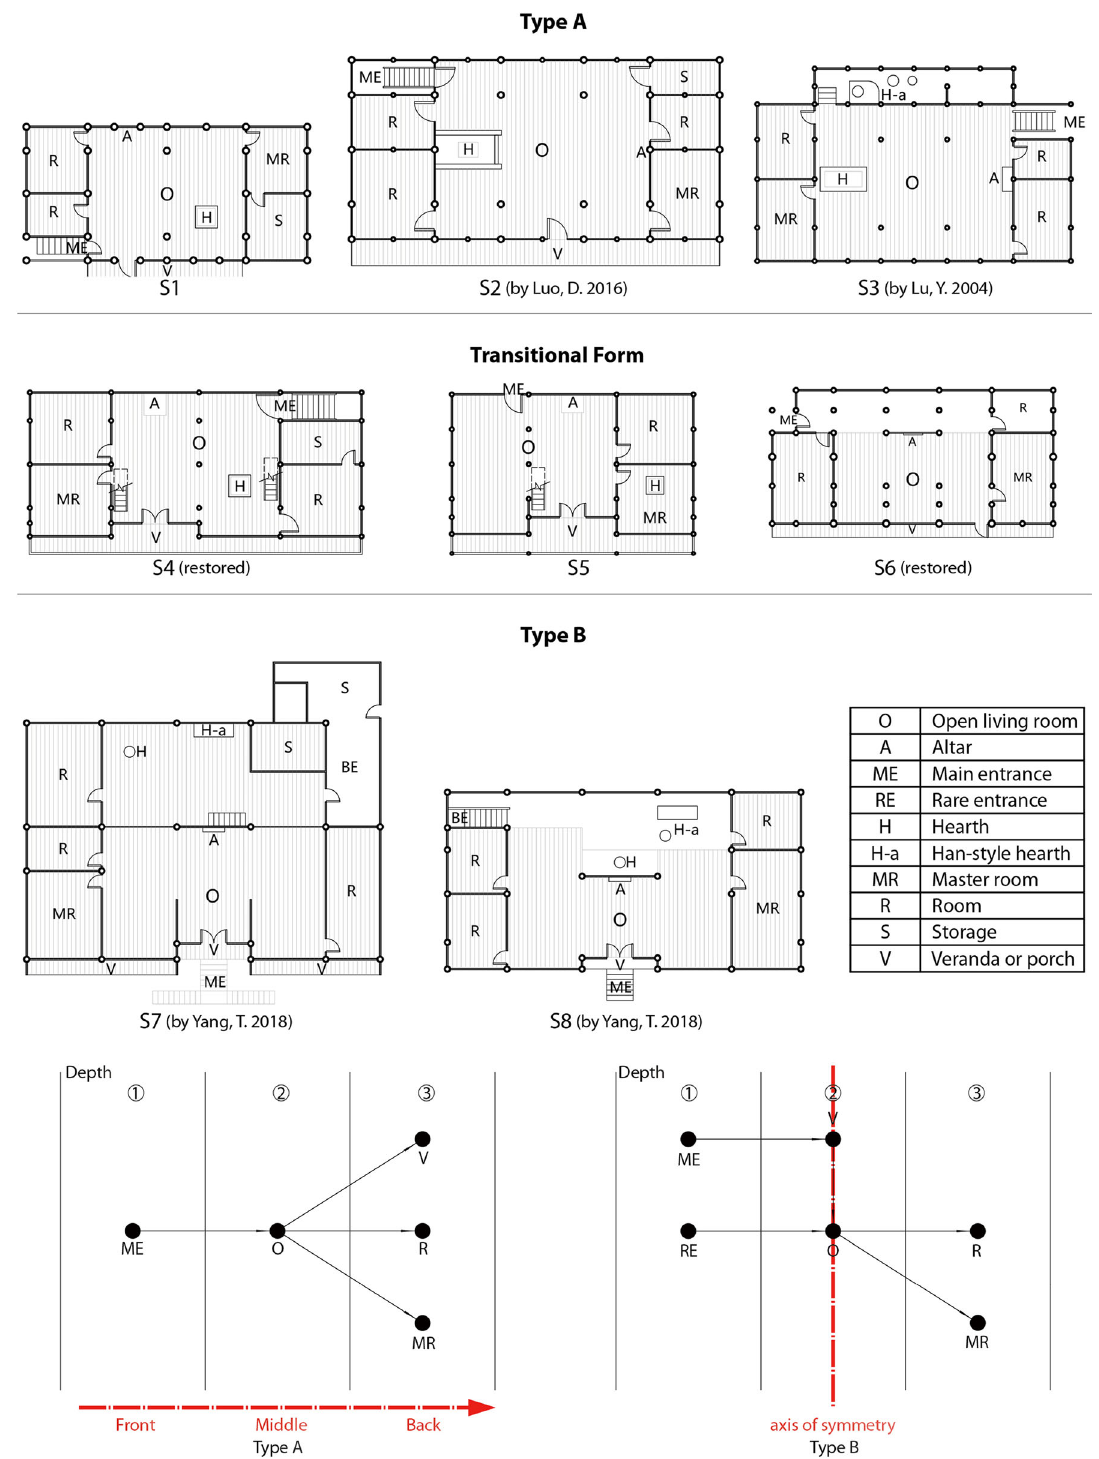
Fig. 5 With eight typical floor plans of Shui houses (from fieldwork and the literature), we analysed the spatial relationship of the two main types, which we evaluated from the spatial depth of their topological relationship. We found that the type-A floor plan had a tree structure with a ‘ front-middle-back ’ layout; the type-B floor plan had a symmetrical ‘ left-middle-right ’ layout (S2, source: Luo and Li 2016; S3, source: Lu 2004; S7 and S8, source: Yang 2018; others, source: the